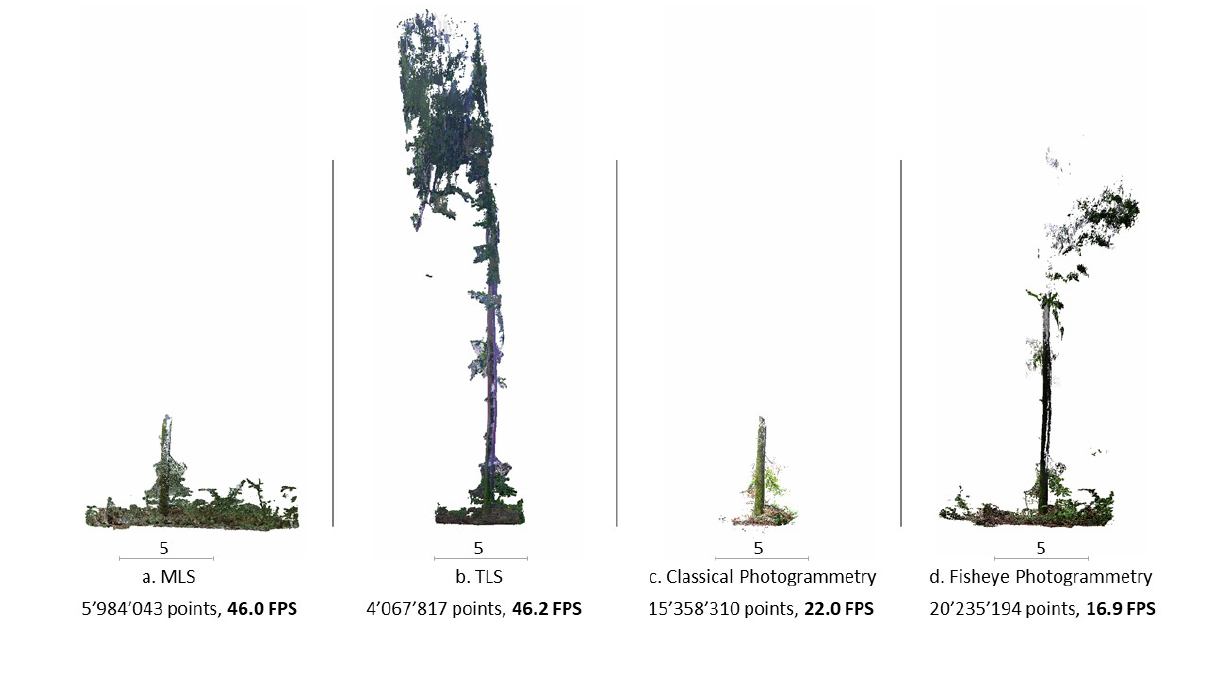
Figure 1. Rendering performance comparison for forest terrestrial 3D scanning methods. Scale bar units are in